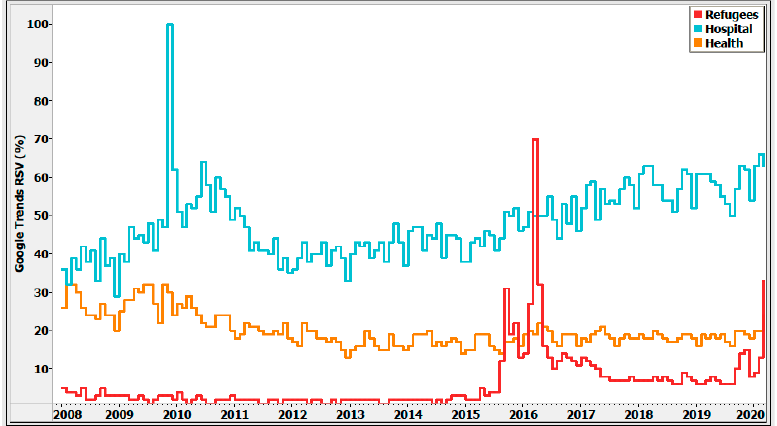
Figure 1. Relative search volume (RSV) for current social issues in Greece (search terms: “refugees”, “health”, “hospital”), January 2008–March 2020. Note: Search volume data provided by Google Trends (https://www.google.com/trends) [4].